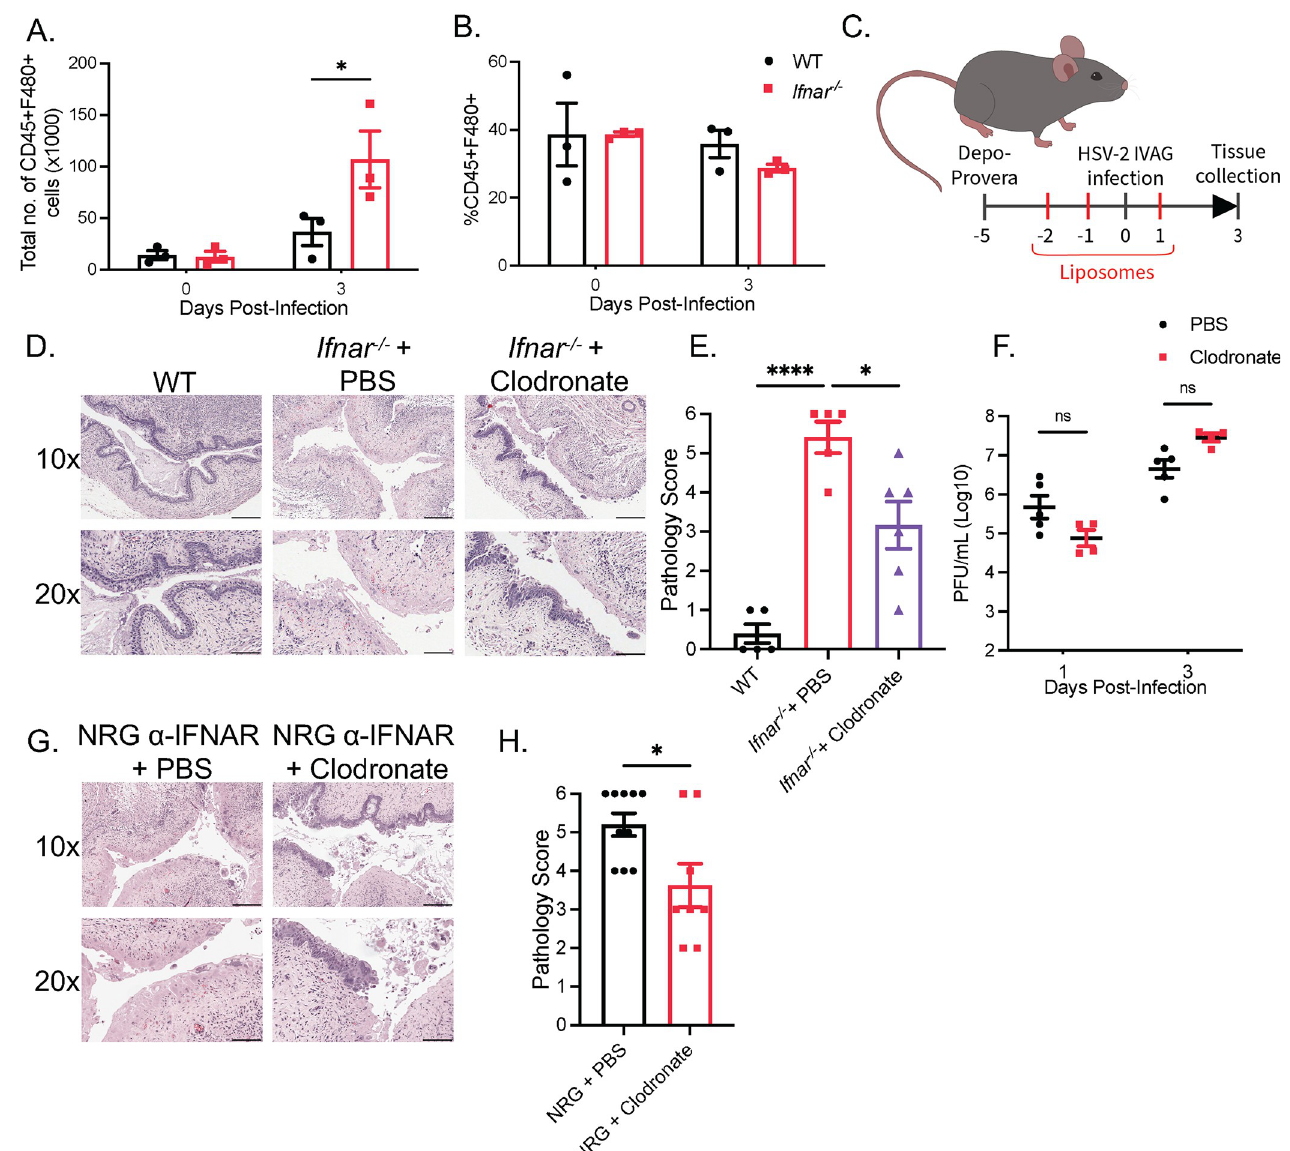
Fig 3. Phagocytic cells are required for HSV-2-induced immunopathology in Ifnar -/- mice. (A) Total number of CD45+F480+ cells in vaginal tissue following infection (n = 5). (B) %CD45+F480+ to total CD45+ cells in vaginal tissue of WT and Ifnar -/- mice at 0 and 3 dpi following HSV-2 infection (n = 5). (C) Schematic of Ifnar -/- mice and NRG mice receiving clodronate or PBS control liposomes. (D) H&E staining of vaginal cross-sections of HSV-2-infected WT and Ifnar -/- mice administered PBS or clodronate liposomes at 3 dpi (n = 5–6). (E) Pathological score of (D). (F) Viral titers of vaginal washes at 1 and 3 dpi of HSV-2-infected Ifnar -/- mice given PBS or clodronate liposomes (n = 4–5). (G) H&E staining of vaginal cross-sections of HSV-2-infected NRG + α -IFNAR Ab mice with PBS or clodronate liposomes at 3 dpi (n = 4–5). (H) Pathology score of (G). 10x scale bar represents 200 μ m, 20x scale bar represents 100 μ m. Data in (A), (B), (E), (F), (H) and are represented as mean ± SEM. � p < 0.05, and ���� p < 0.0001 (A, B, F, two-way ANOVA; E, one-way ANOVA; H, two-tailed t-test). See also S3 Fig.